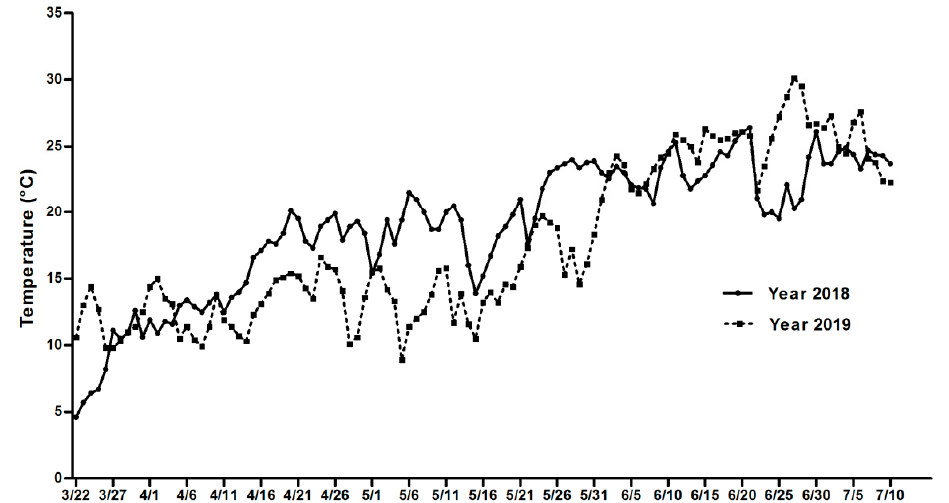
Figure 2. Average daily air temperatures at 2 m above the ground during spring 2018 and 2019 in Legnaro (Padova), northeastern